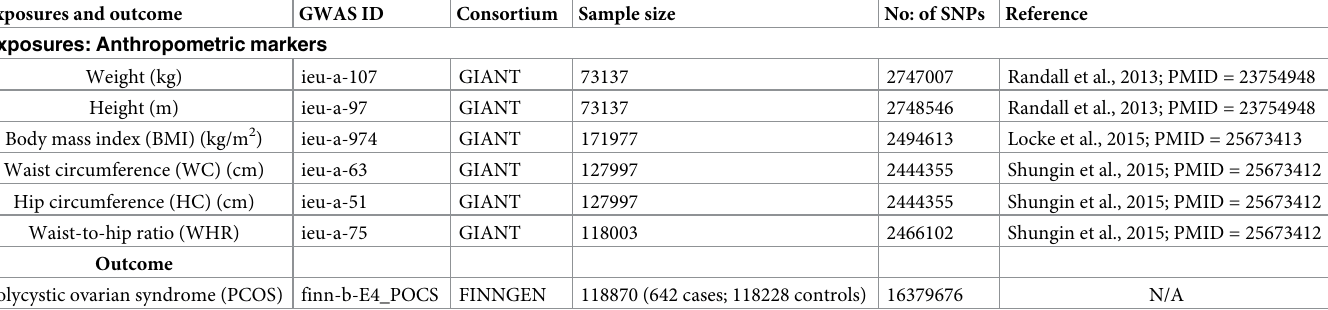
Table 1. Female-only, European ancestry GWASs retrieved from the IEU Open GWAS project to be included as exposures (anthropometric markers) and the out- come (PCOS) in two-sample Mendelian randomization analyses. Exposures and